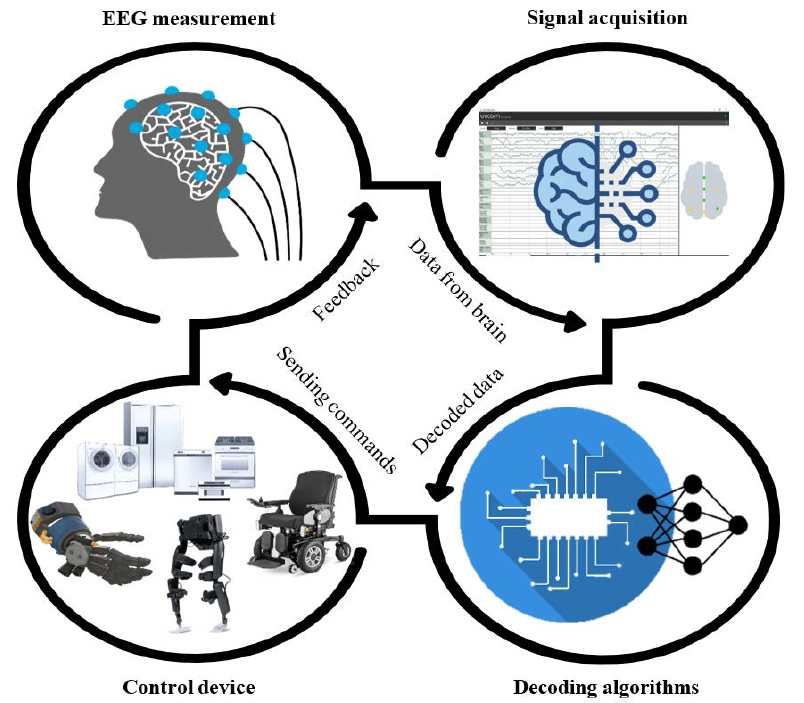
Figure 1. Brain–computer interface